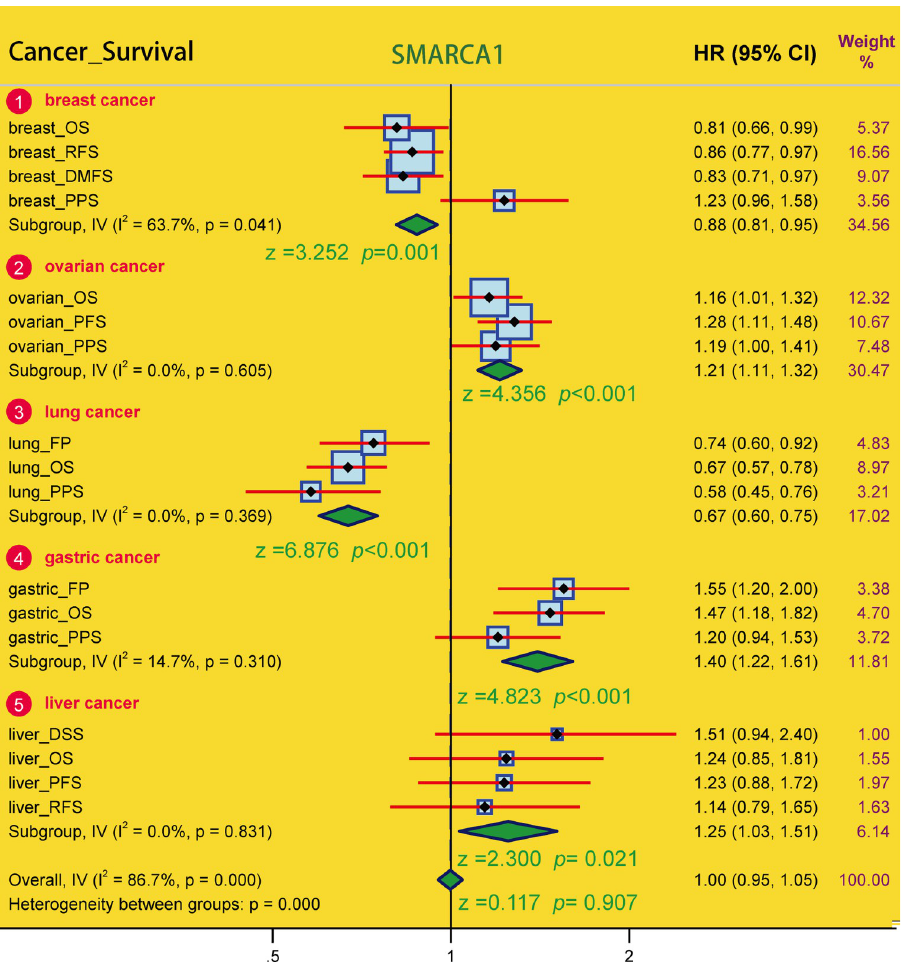
Fig 7. Meta-analysis on the relationship between SMARCA1 expression and multiple factors of various tumor prognosis. A series of subgroups survival analyses in breast, ovarian, lung, gastric and liver cancer were conducted with z-test, � P < 0.05, �� P < 0.01, ��� P < 0.001.